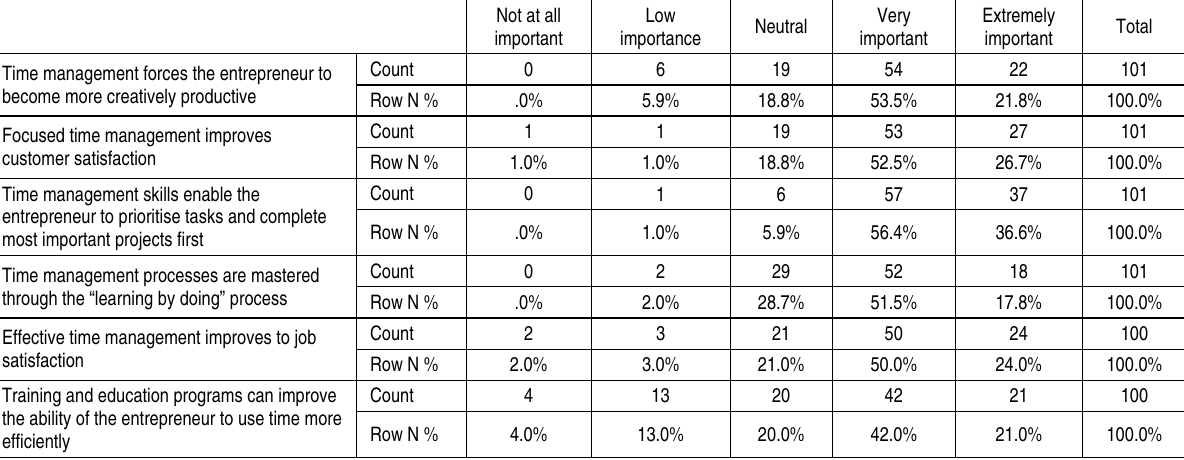
Table 4. The skill of time management – level of importance